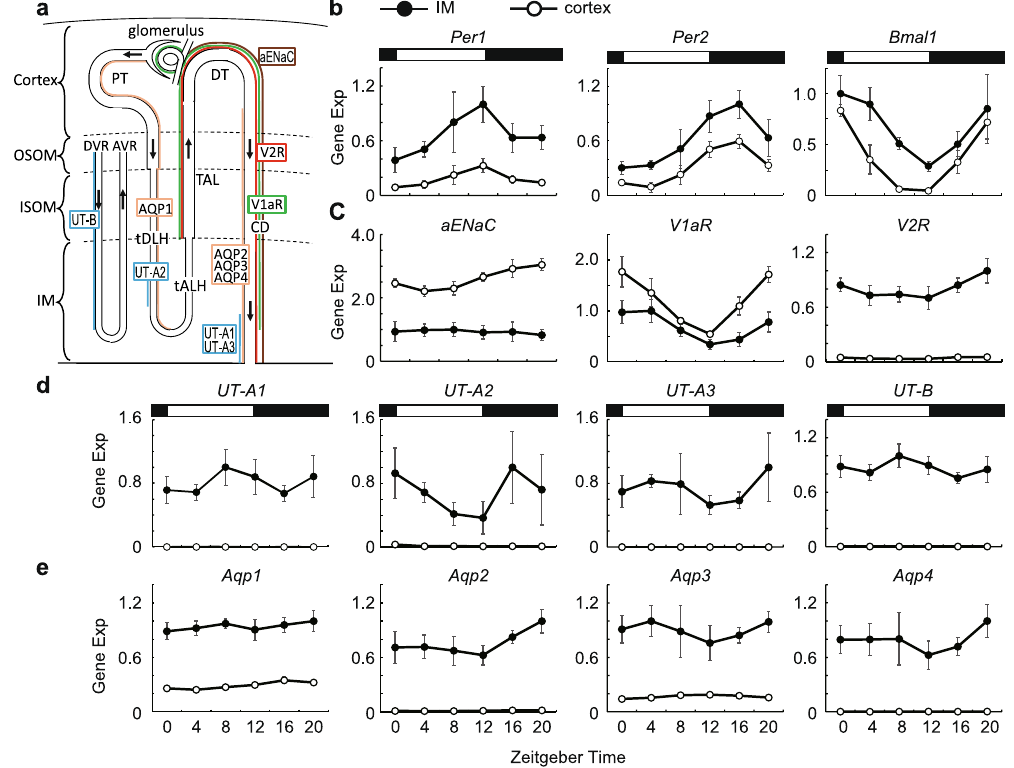
Figure 3. Clock genes and genes contributing high osmotic pressure gradient and water re-absorption in mouse kidney. ( a ) Diagrammatic representation of the localization of analized genes in the long-looped nephron and vasa recta. Aqp1 is expressed in proximal tubules (PT) and thin descending limbs of Henle’s loop (tDLH) (orange). Aqp2 , Aqp3 , and Aqp4 are expressed in the collecting ducts (CD) (orange). V1aR is expressed the thick ascending limbs (TAL) of Henle’s loop, distal tubule (DT), and the CD except for deeper third of the inner medullary CD, and glomerulus (green). V2R is expressed in the TAL, DT, and the CD (red). UT-A1 and UT-A3 are expressed in the deepest part of the inner medullary CD (blue). UT-A2 is expressed in a limited portion of tDLH (blue). UT-B is expressed in the descending vasa recta (DVR) throughout the medulla (blue). aENaC is expressed the DT and the CD (brown). The other abbreviations used are: OSOM, Outer stripe of outer medulla; ISOM, Inner stripe of outer medulla; IM, Inner medulla; AVR, ascending vasa recta; tALH, thin ascending limb of Henle. ( b – e ) Diurnal variations of Per1 , Per2 , Bmal1 ( b ), aEnac , vasopressin receptors ( c ), urea transporters ( d ), and water channels ( e ). Each gene expressions in the IM ( • ) and cortex ( ⚬ ) are shown. Data were normalized to 18S ribosomal RNA (mean values ± S.D, n = 6). White and black rectangles in graphs indicate the light phase and the dark phase,